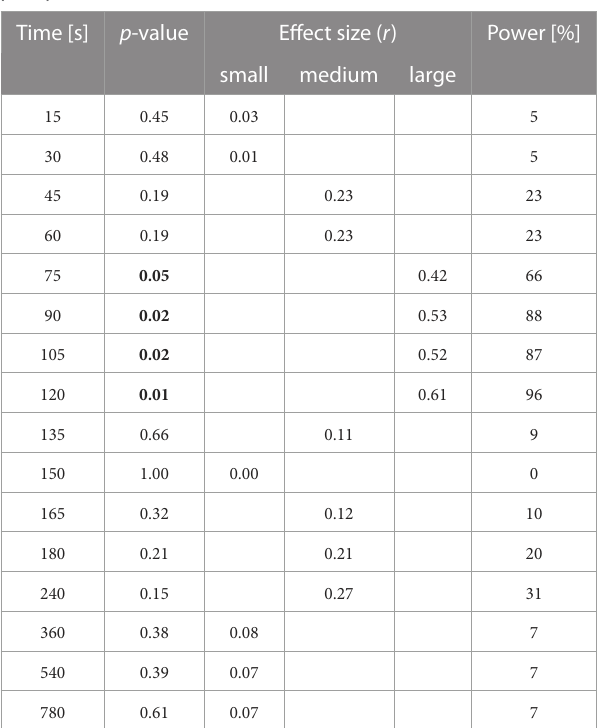
TABLE1 StatisticalanalysisofdifferencesbetweenthetimecourseofCCI recordingsbeforeandaftertrainingForeachtimepointduringexerciseand therecoveryperiod, p -values,theeffectsize r ,andthestatisticalpowerare reported,basedonWilcoxonsignedranktest.Dependingonthevalueof r ,